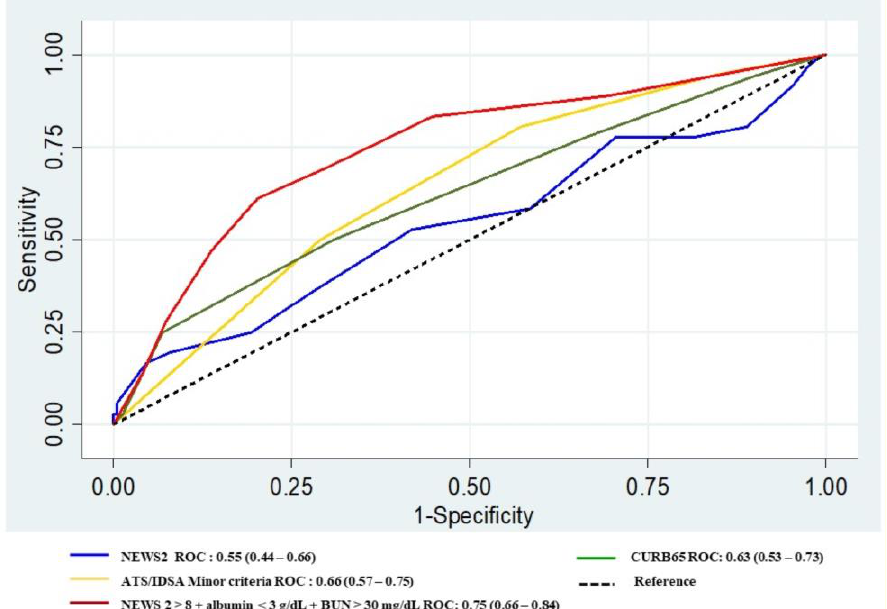
Figure 2. AUROC of NEWS2, IDSA/ATS minor criteria, and CURB65, to predict hospital mortality in patients with